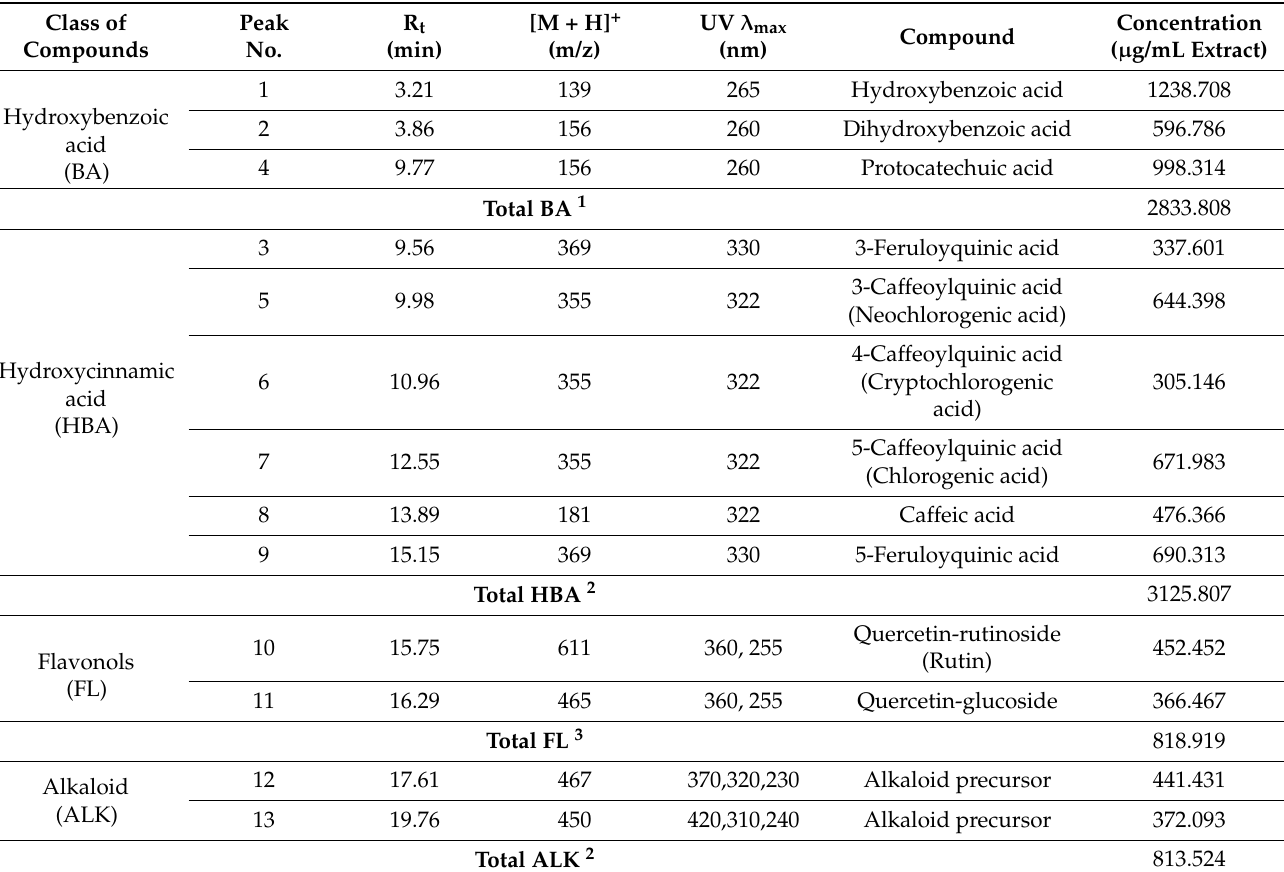
Table 1. Tentative identification and quantification of phenols and alkaloids in the methanolic extract of S. bulbocastanum leaves. R t —retention time; [M + H] + —molecular ion; UV λ max—wavelengths of maximum absorption in the visible